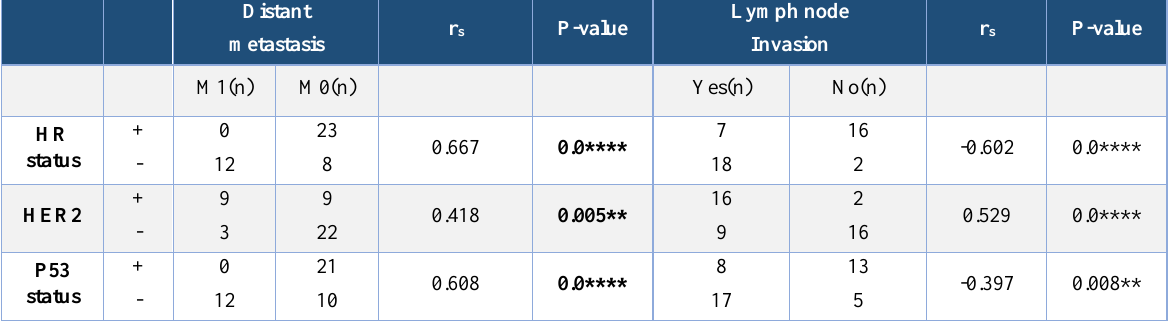
Table 7. Correlation analysis of distant metastasis and lymph node invasion, with HR status, HER2 expression, and P53 mutation status in BC patients (n=43). Results of Spearman correlation test.